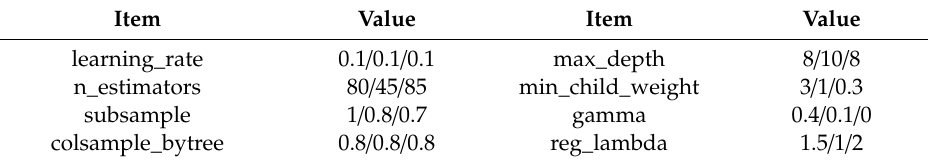
Table 2. Hyper parameters of XGBoost (Kx, Ky, Kz).